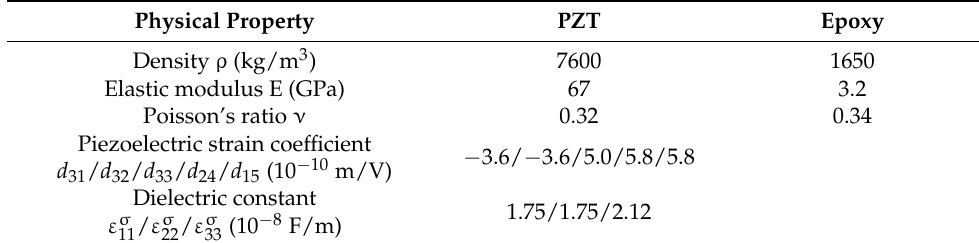
Table 1. Physical properties of PZT and epoxy.